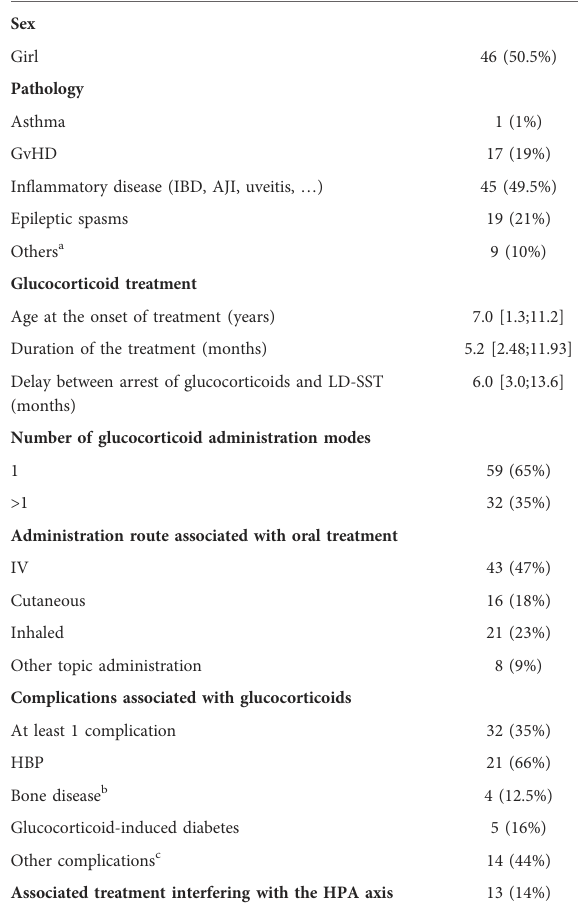
TABLE 1 Population